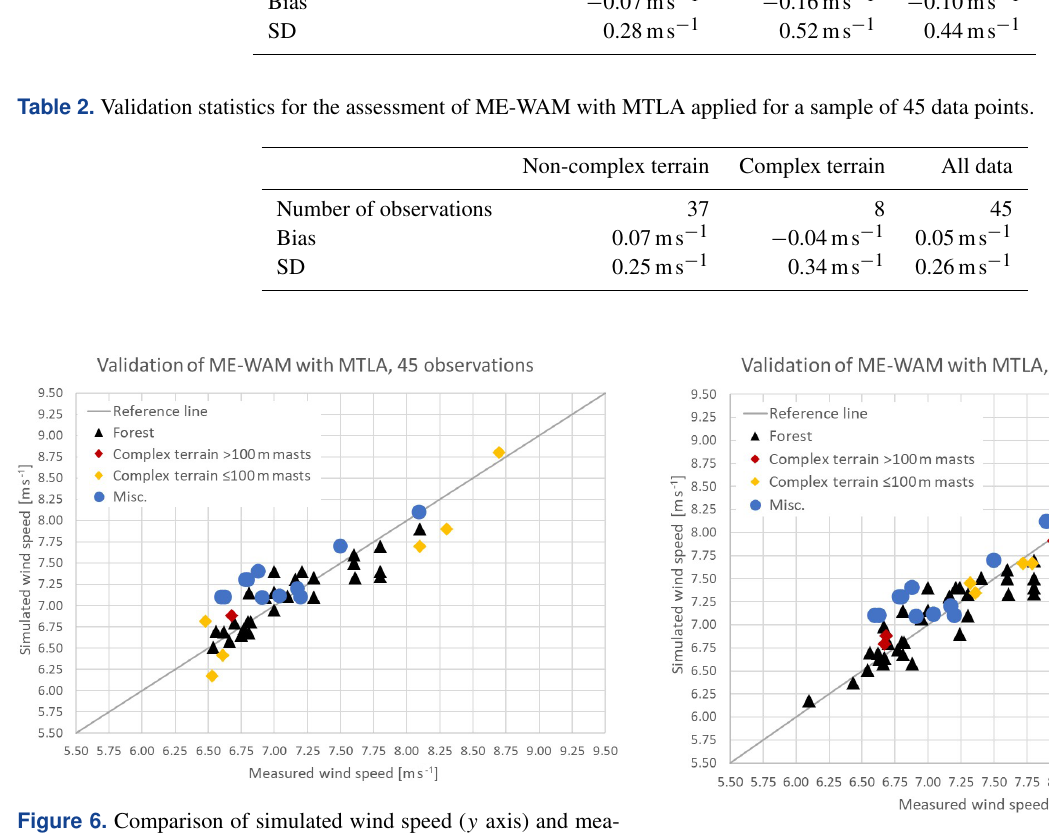
Figure 7. Comparison of simulated wind speed ( y axis) and mea- sured wind speed at the meteorological mast ( x axis) for 80 data points after MTLA is applied to all data points (note that this in- cludes a reanalysis of the data points in Fig. 5 to include